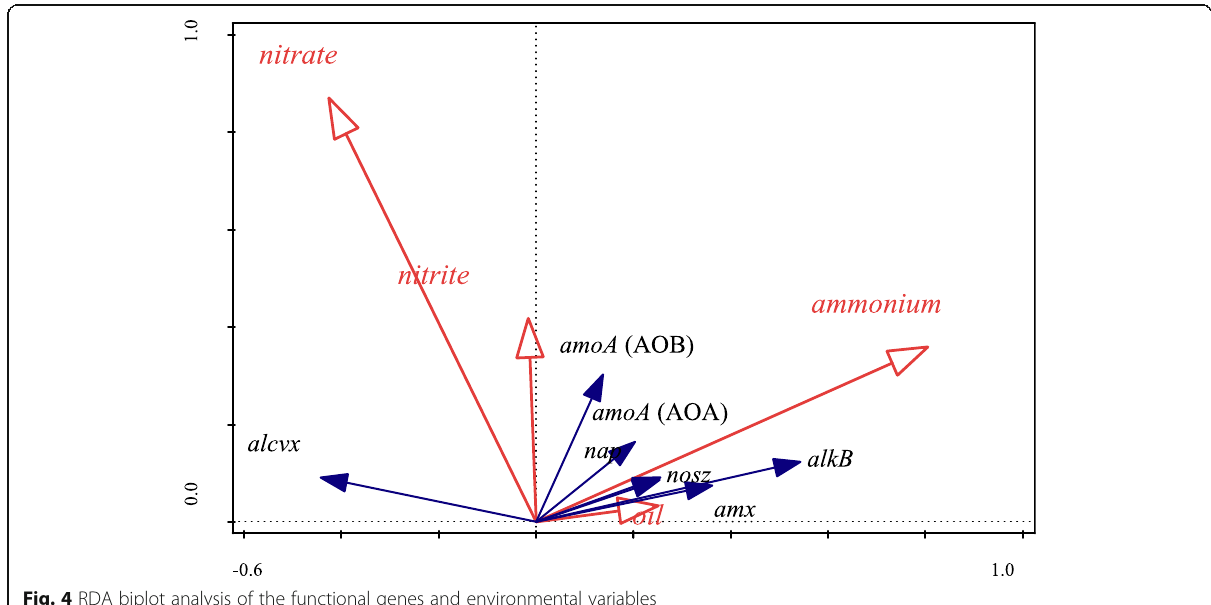
Fig. 4 RDA biplot analysis of the functional genes and environmental